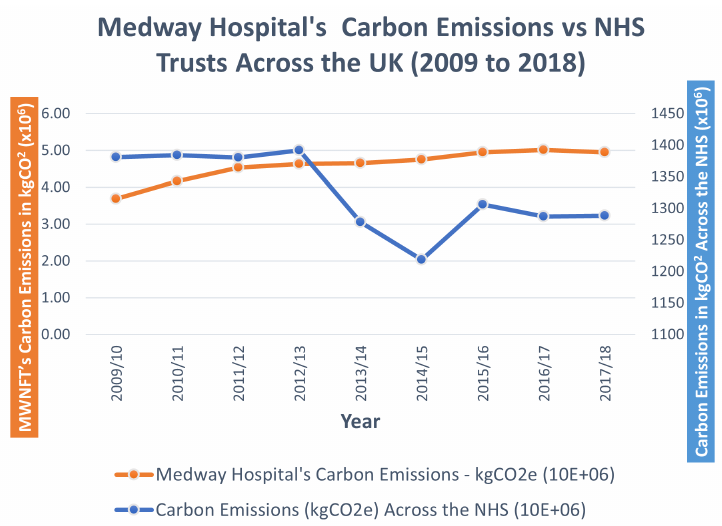
Figure 1. Medway hospital’s carbon emissions compared to NHS Hospitals across the UK (2009 to